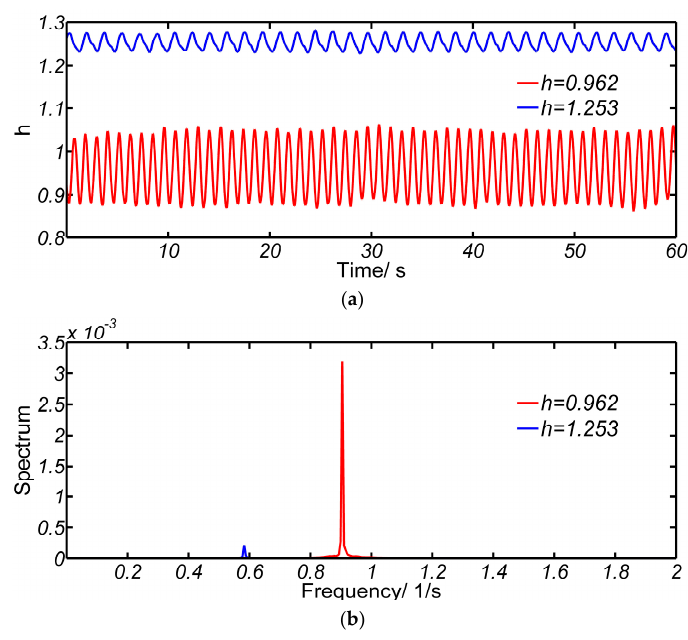
Figure 6. ( a ) Water level oscillation for two different water levels, h = 0.962 and h = 1.253 in Case 3; ( b )